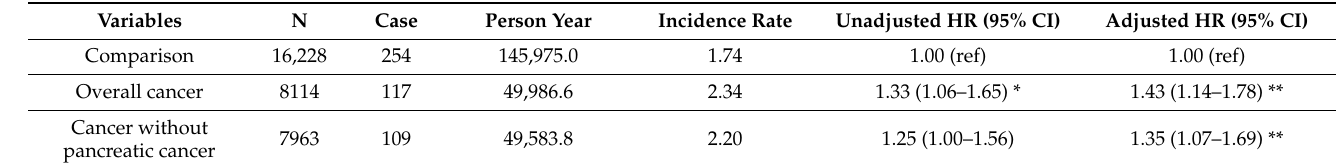
Figure 4. Risk of requiring insulin treatment in patients with liver, gallbladder, pancreas, lung, and hematologic malignancy by time. Table 2. Sensitivity analysis: incidence and risk of insulin treatment in patients with cancer who excluded those diagnosed with pancreatic